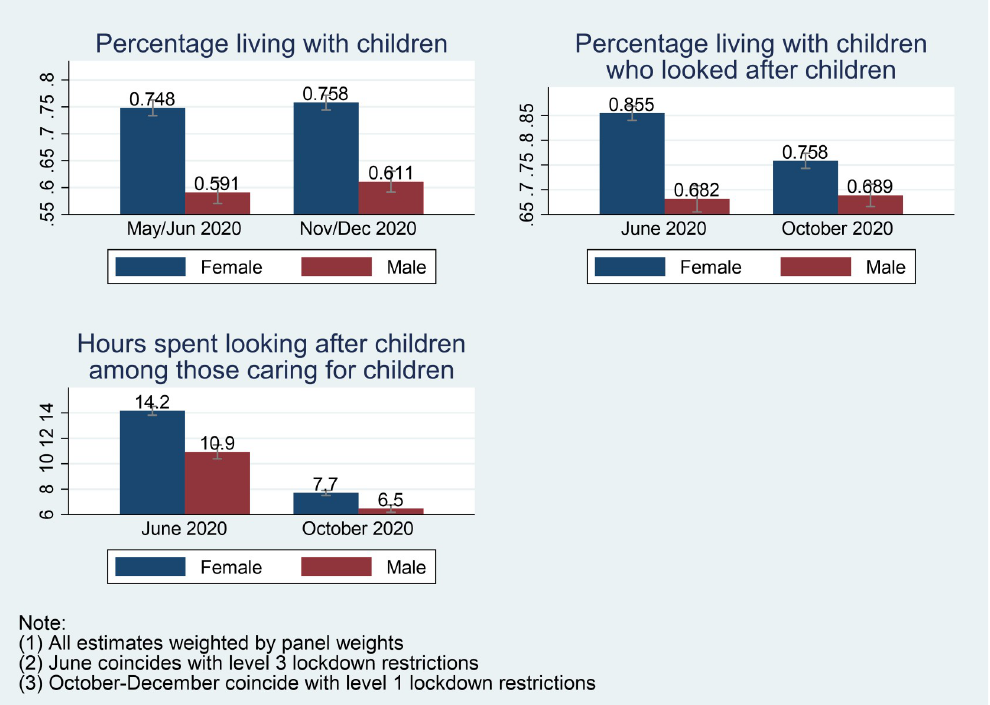
Fig 1. Depicts the gendered division of labour regarding